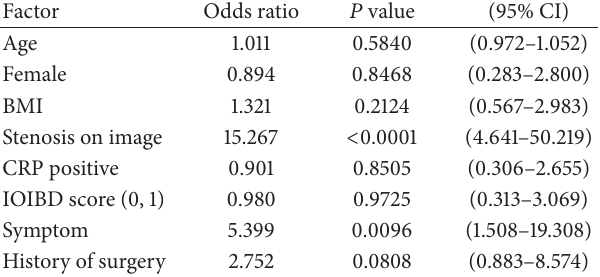
Table 6: Factors affecting the role of DBE—univariate analysis.